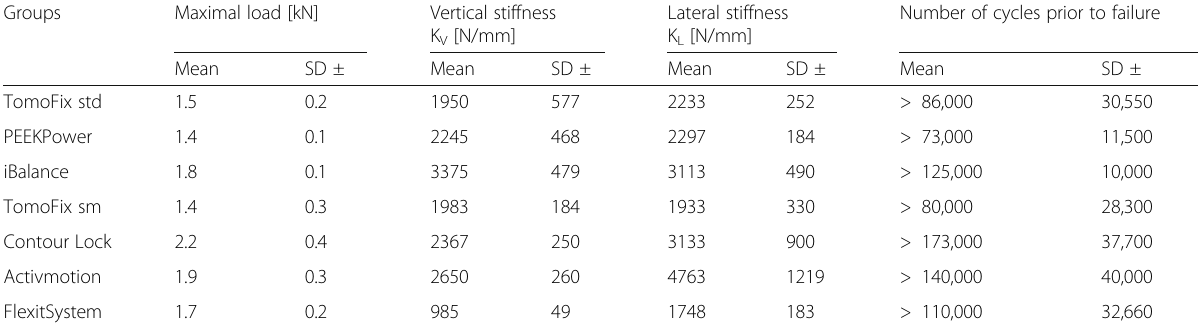
Table 8 Average mean values, including the standard deviations (SD), per group of the cyclic fatigue to failure